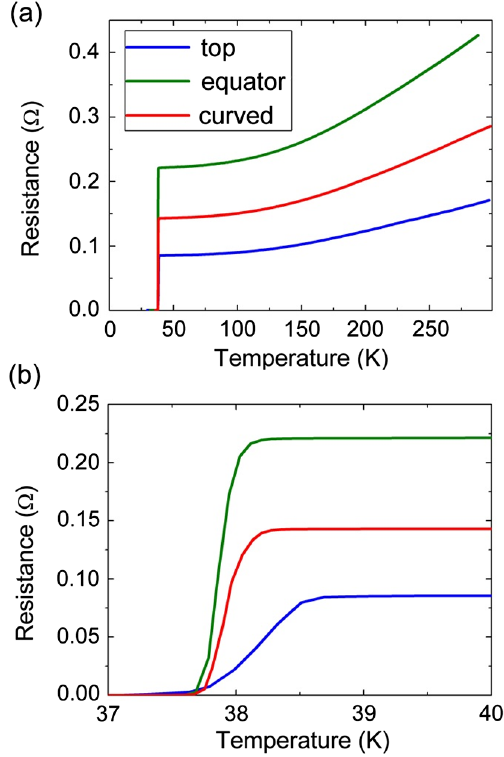
FIG. 11 (color online). (a) Resistivity versus temperature for the top three samples from the two-step process. (b) Close-up of the transition edge.